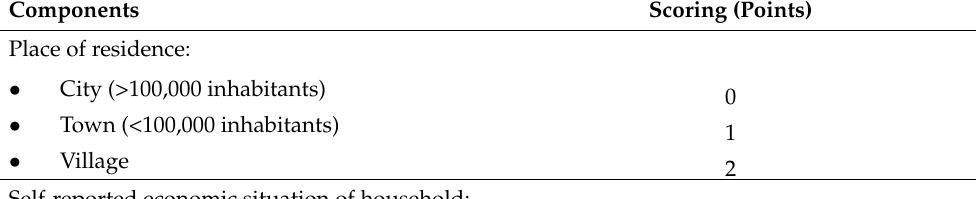
Table 3. The Socioeconomic Status Index (SESI)—component data and scoring.